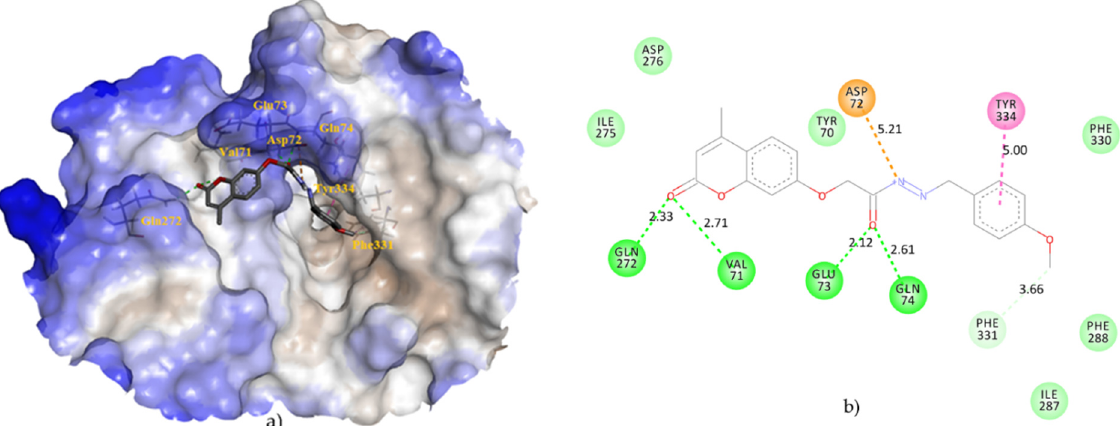
Figure 3. The main interactions of compound 9 with residues in the binding site of AChE (pdb ID: 2C5G): ( a ) Hydrophobic surface representation of AChE active site with docked compound 9 . Hydrophobicity in range: 3 (brown) to − 3 (blue); ( b ) Two-dimensional diagram of main interactions with interatomic distances (Å). Green = conventional hydrogen bonds; light green = van der Waals; pale green = carbon hydrogen bond; brown = attractive charge; pink = π – π T-shaped interaction. Table 7. Molecular properties of coumarinyl Schiff